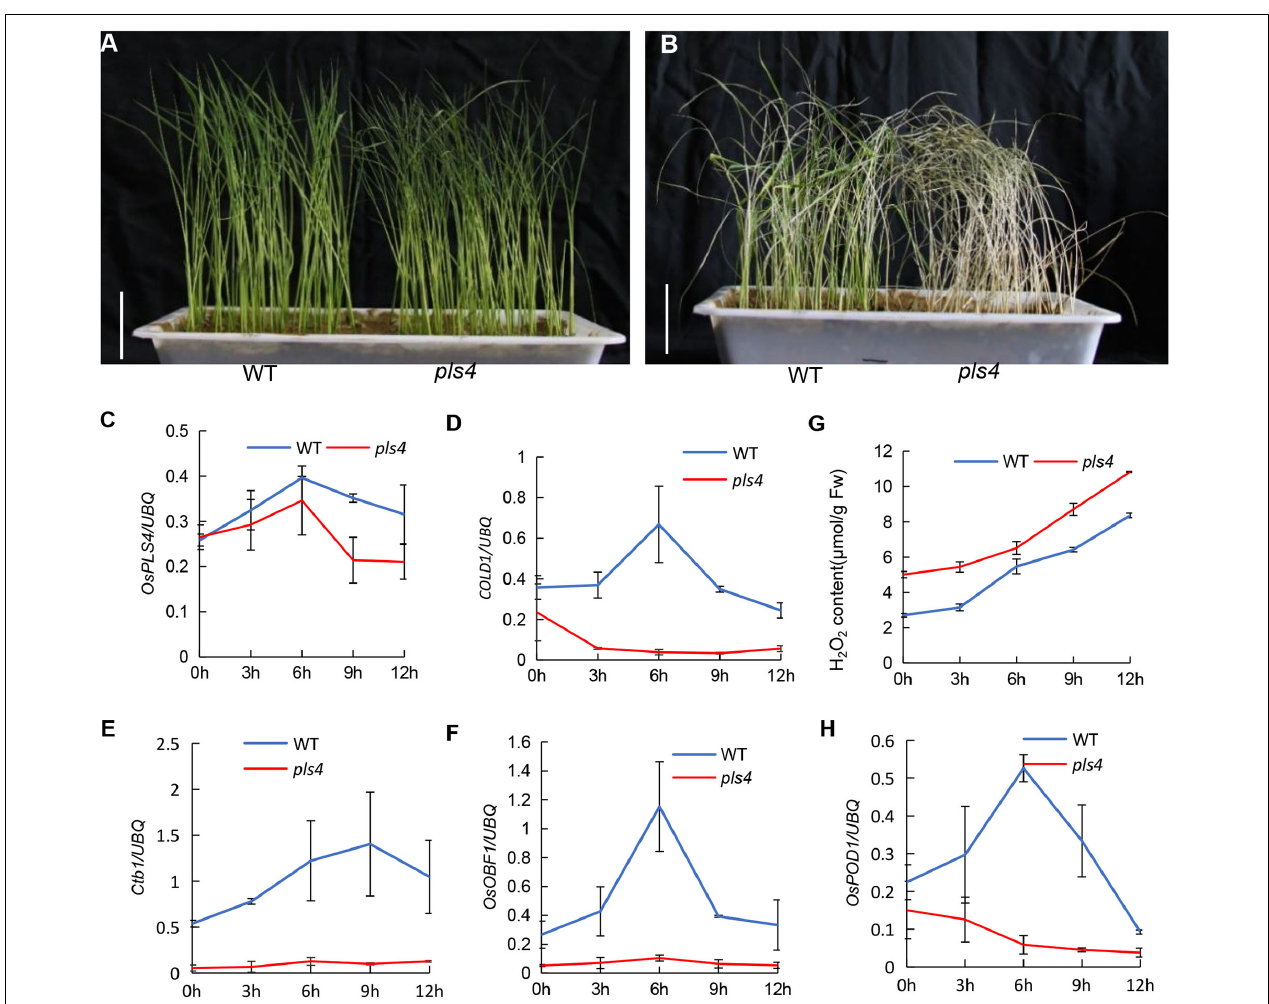
FIGURE 6 | Chilling stress at the seedling stage and related gene expression analysis. (A) The WT and pls4 mutant treated at 4 ◦ C for 72 h. Bar = 5 cm. (B) The WT and pls4 mutant treated at 4 ◦ C for 72 h, followed by recovery at 30 ◦ C/25 ◦ C day/night for 7 days. Bar = 5 cm. (C–F) Relative expression of OsPLS4 and genes associated with cold tolerance at different chilling treatment times for the WT and pls4 mutant. The genes included COLD1 (LOC_Os04g51180), Ctb1 (LOC_Os04g52830) and OsOBF (LOC_Os12g37410). (G) H 2 O 2 content in the WT and pls4 mutant at different chilling treatment times. (H) Relative expression of OsPOD1 (peroxidases) in the WT and pls4 mutant at different chilling treatment times. The data presented are the means ± SDs from three biological